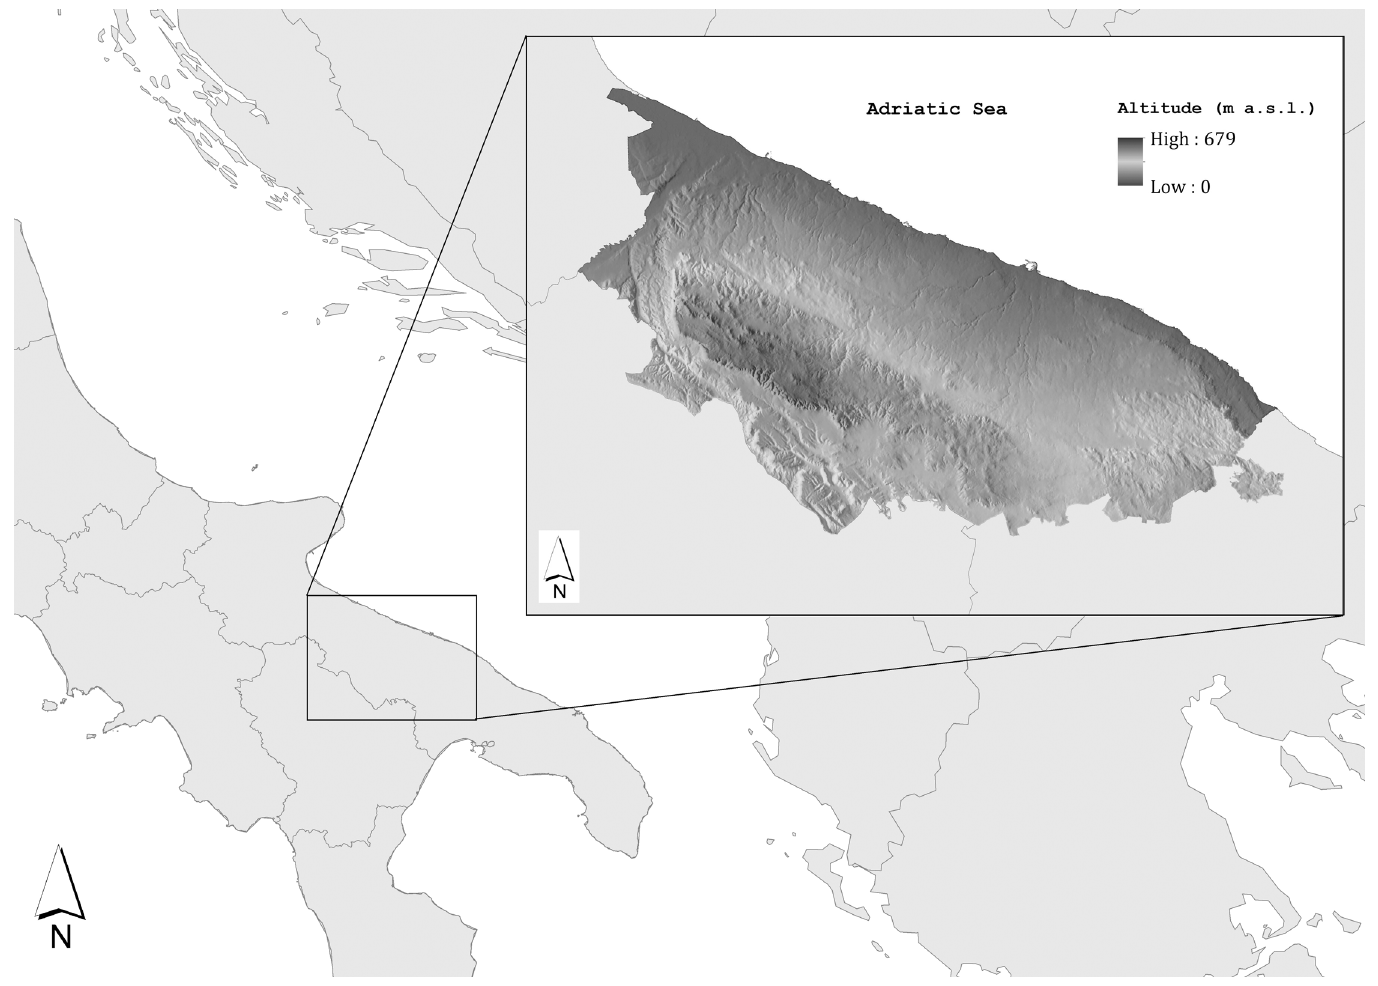
Fig 1. The study area in Central Apulia (southern